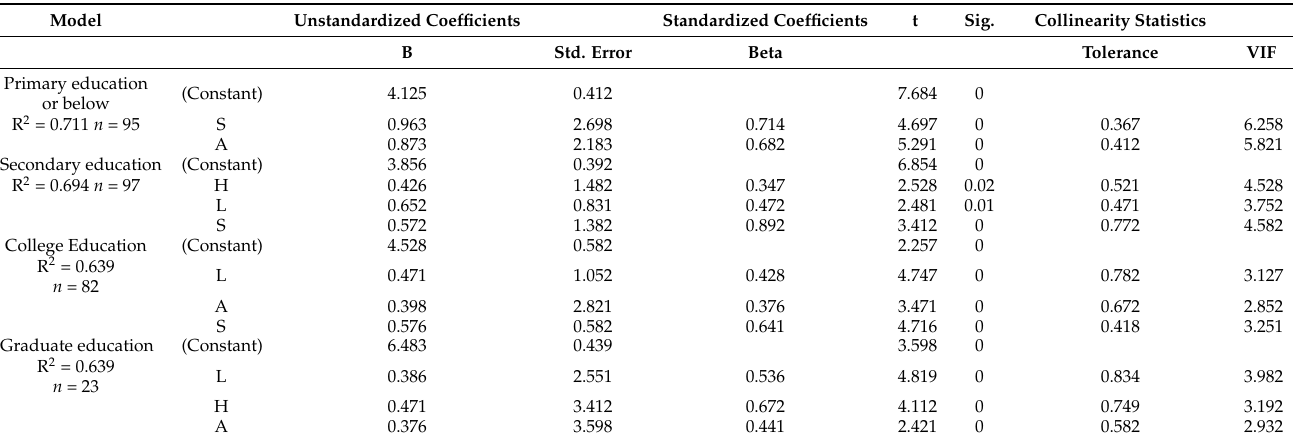
Table 11. The linear regression analysis of photos’ physical properties for groups with different education